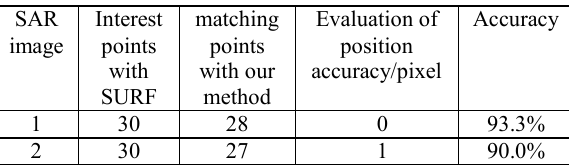
Figure 3. The result of SURF